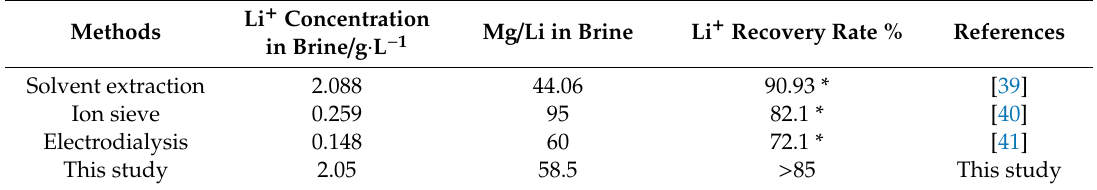
Table 10. Comparison of the Li + recovery between this study and conventional